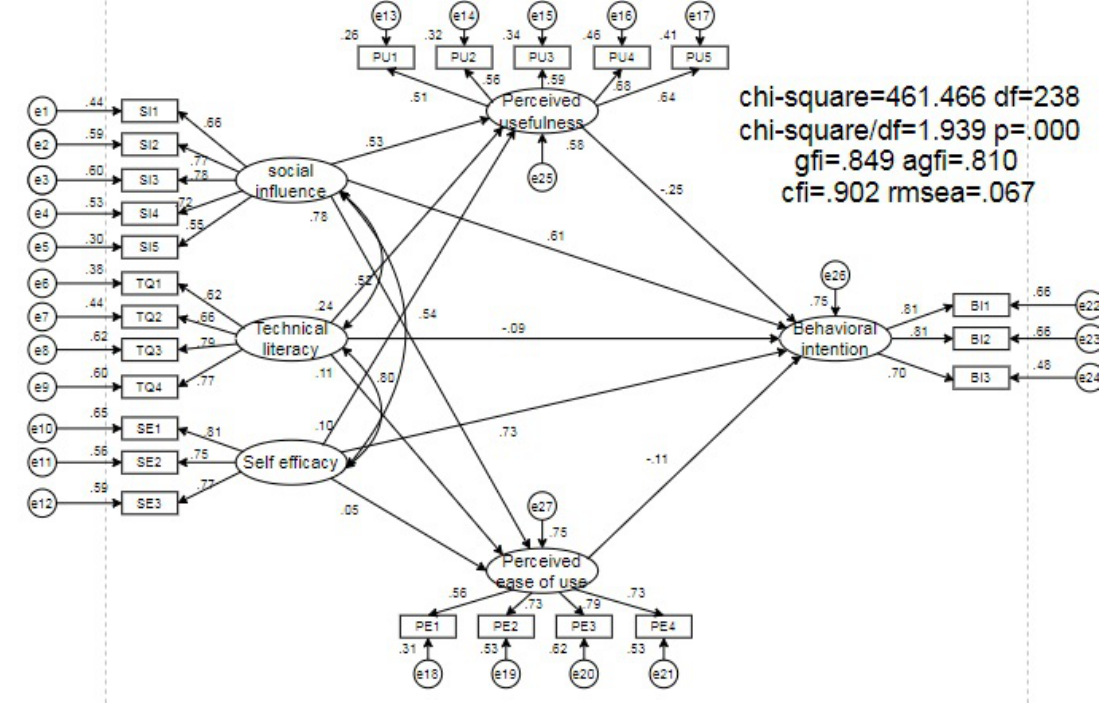
Fig. 7 Results of the validation factor